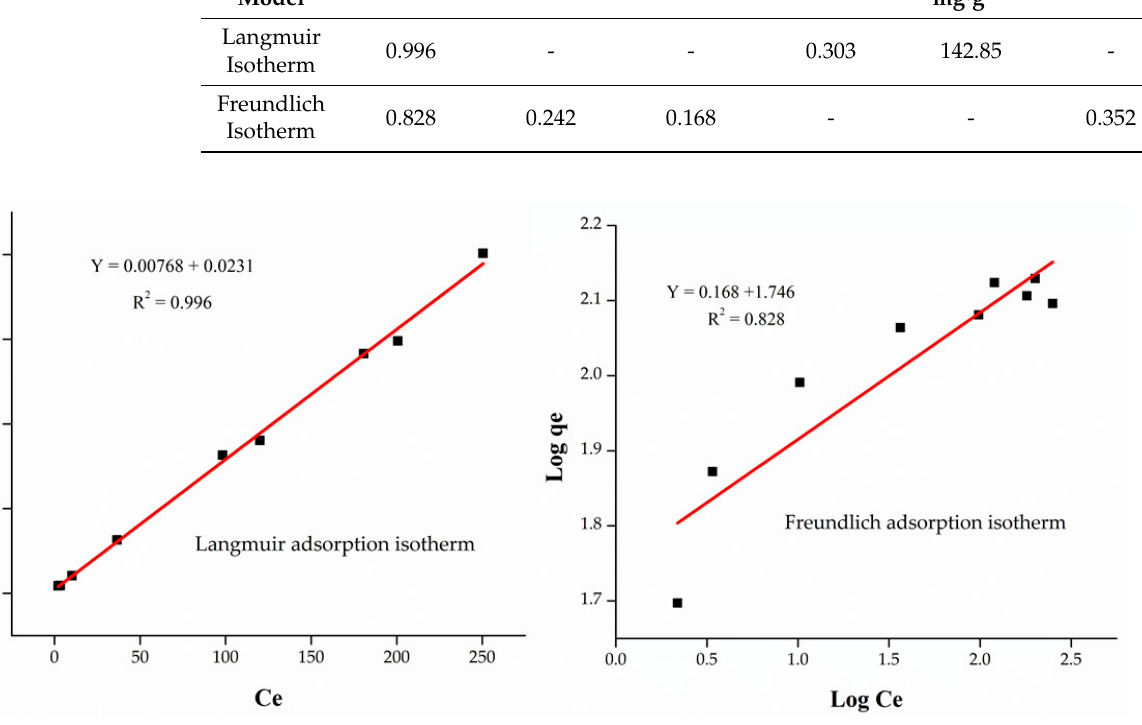
Figure 7. Plots of Langmuir and Freundlich adsorption isotherms for adsorption of Cr (VI) over M-AC.